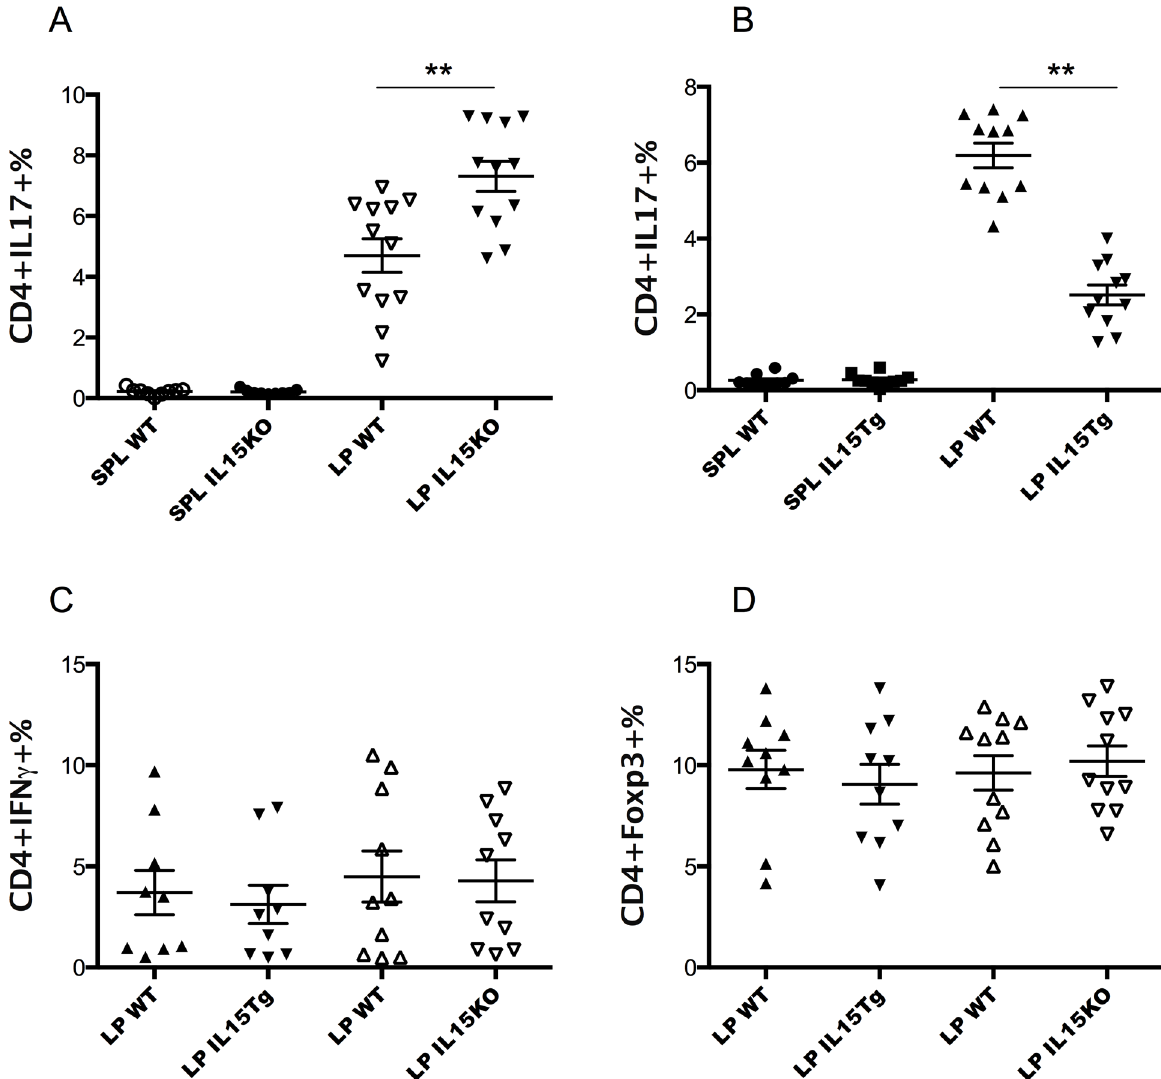
Fig 1. Differences in Th17 cell frequencies in the LP of IL-15 Tg or KO mice, but not in frequencies of Th1 or Treg cells. Cells from spleen and small intestine LP were stimulated for four hours with PMA and ionomycin and stained with surface markers CD3 and CD4, followed by intracellular staining of IL- 17, IFN γ or Foxp3. A. Higher frequencies of Th17 cells were found in the LP of IL-15 KO mice than matched co-caged WT mice (p < 0.001 by Mann-Whitney). B. IL-15 Tg mice showed significantly lower frequencies of Th17 cells in the LP compared with their co-caged WT littermates (the littermates were considered as matched WT controls) (p < 0.001 by Mann-Whitney). C. The frequencies of IFN γ -producing CD4 + T cells were not significantly different in the LP of IL-15 KO vs WT and IL-15 Tg vs littermate WT control. D. The frequencies of CD3 + CD4 + Foxp3 + cells were not significantly different in small intestinal LP of IL-15 KO vs WT and IL-15 Tg vs littermate WT control. This figure pools data from several independent experiments with similar results. D ouble asterisk ( ** denotes P < 0.001).